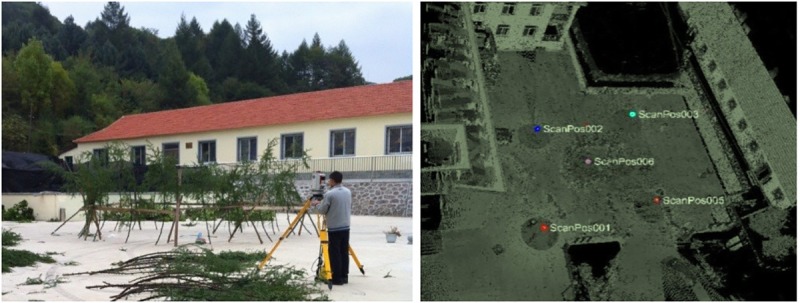
Position layout.